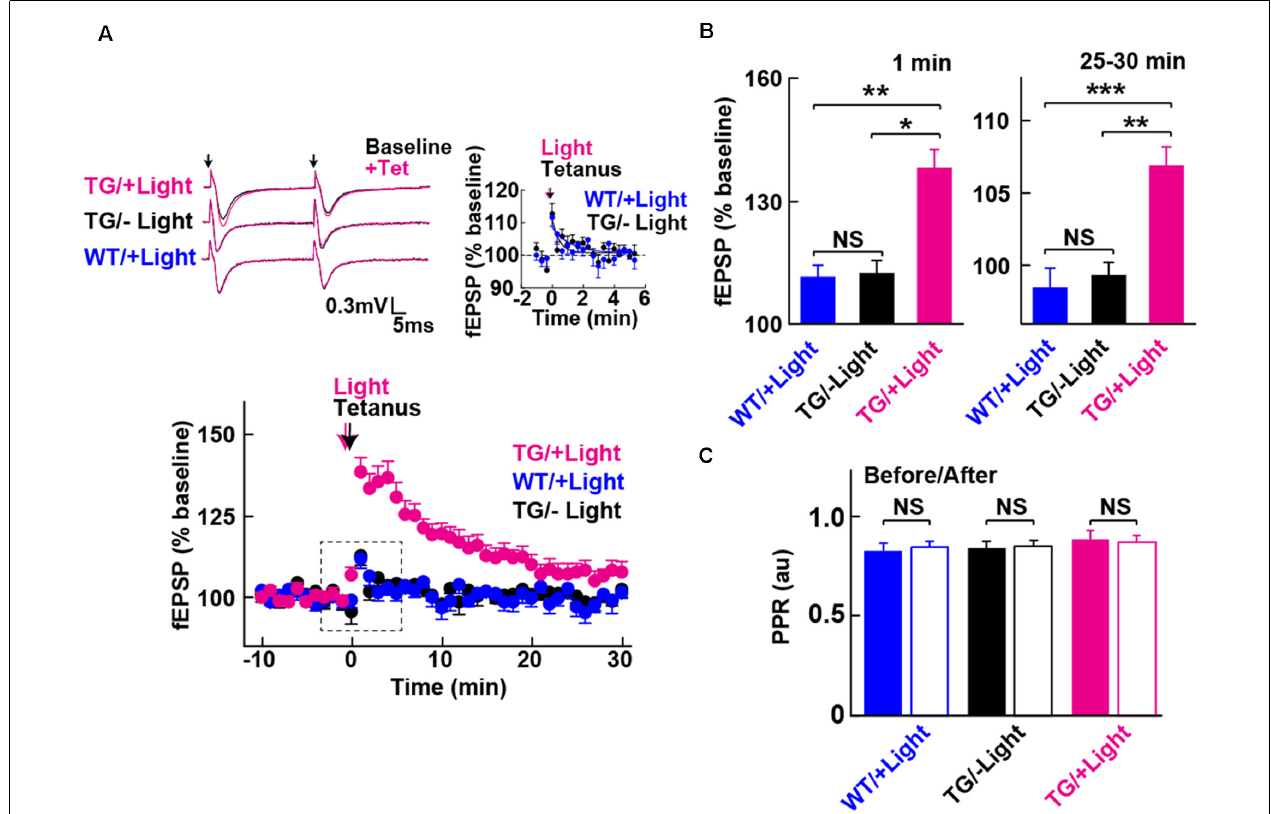
FIGURE 3 | Long-term potentiation (LTP) enabled by photoactivation of PAC. (A) Lower: Blue light (480 nm, 5 min) photoactivation of PAC during tetanic stimulation (100 Hz × 4 trains, arrow) of MPP-DG synapses evoked potentiation of responses that persisted for 30 min. Hippocampal slices from WT mice receiving light, as well as Tg slices not receiving light, showed a transient and relatively small potentiation lasting about a minute ( − Light, TG n = 10 slices/3 mice, +Light, TG n = 11 slices/7 mice, +Light, WT n = 13 slices/3 mice). Left upper: sample paired-pulse traces (scale bar of 0.3 mV and 5 ms) show superimposition of the fEPSP response before (Baseline; black) and 1 min after (+Tet; magenta) tetanic stimulation. Black arrows indicate the time of single pulses of stimulation. Right upper: comparison of post-tetanic potentiation within the boxed region in the lower graph showing the fEPSP normalized slope in expanded detail for the two control conditions, WT littermates in the presence of blue light (cyan) and Tg animals without blue light (black). (B) Quantification of synaptic potentiation at 1 min and 25–30 min after tetanus (A) . * p < 0.05, ** p < 0.01, *** p < 0.001 (Tukey test). (C) Comparison of PPR before ( − 10 to 0 min) and after the tetanic stimulation (10–20 min) in the three conditions revealed no statistically significant differences (sample size identical to A). NS, p > 0.05 (paired t -test). All data displayed are mean ±